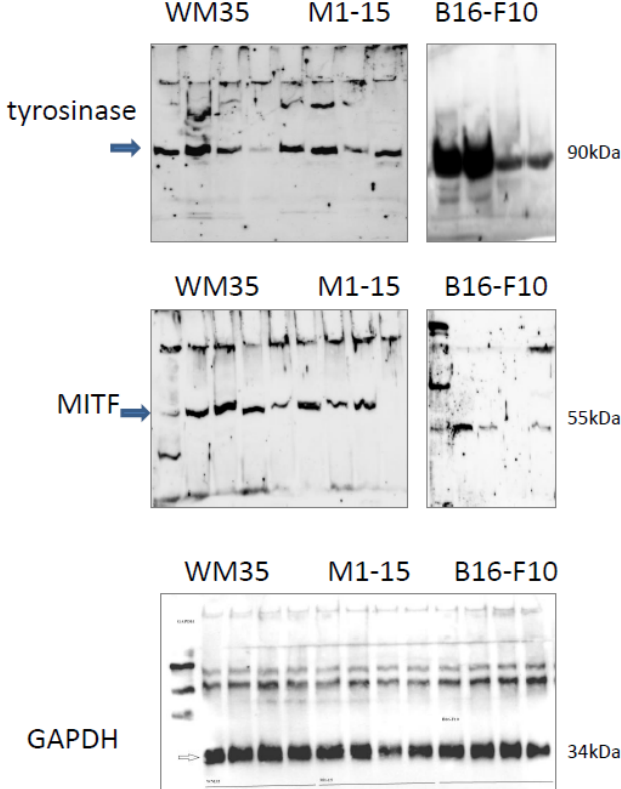
Figure A2. Original images WB Figure 5.